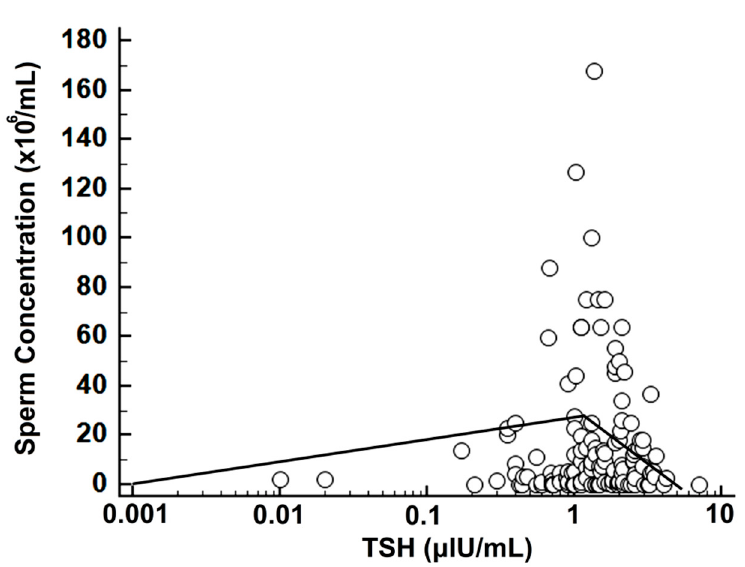
Figure 3. Scatterplot of logTSH versus sperm concentration with SR; note the logarithmic scale for TSH and the biphasic regression line with a breakpoint at TSH = 1.22 μ IU/mL.